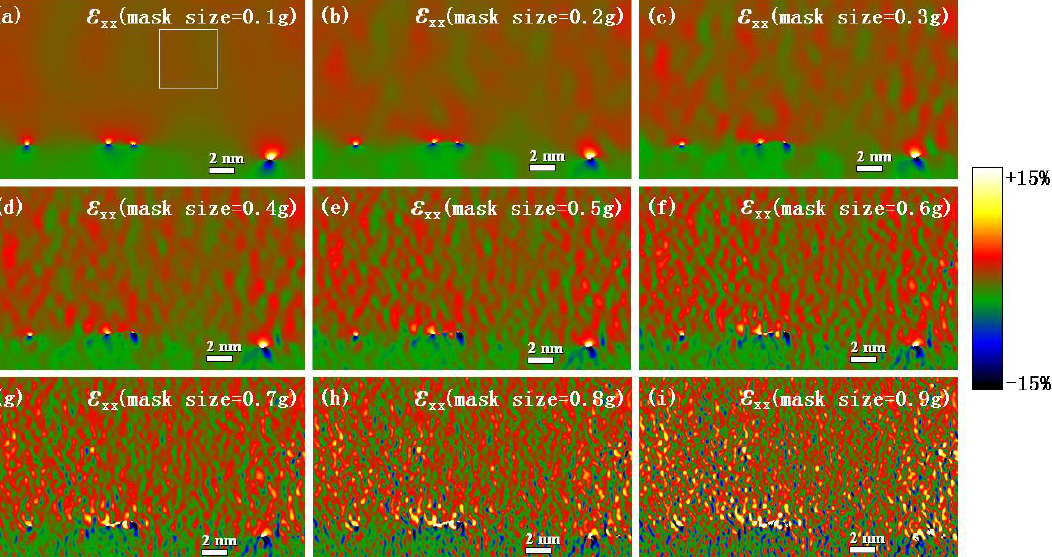
at the Ge/Si heterostructure interface xx